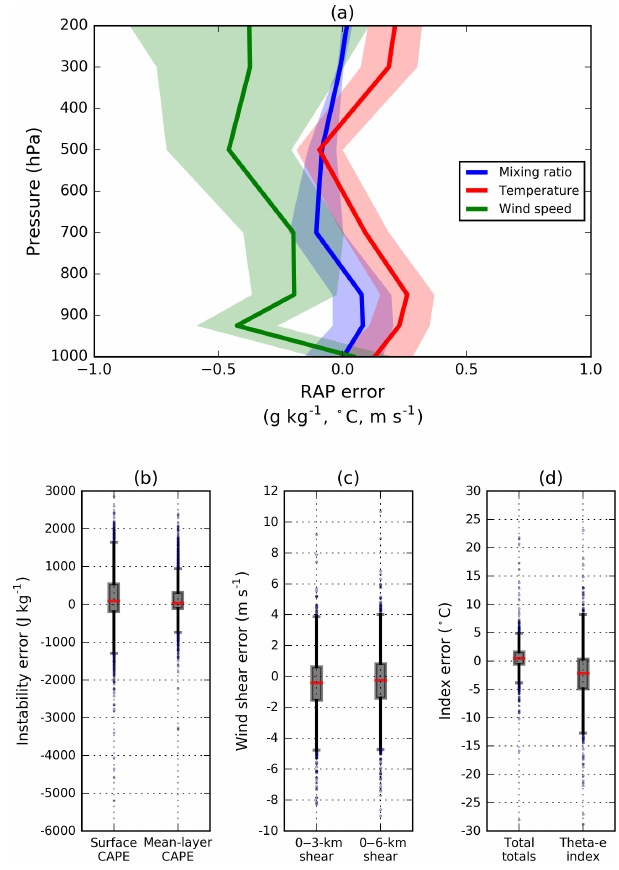
Figure 2. Vertical profiles of RAP output errors measured by co- located radiosonde observations (a) . Errors were calculated at 1000, 925, 850, 700, 500, 300, and 200hPa. The 95% confidence interval for the mean error (solid lines) is shaded. Box plots of the result- ing error for six derived quantities is shown in panels (b–d) . The interquartile range (IQR), representing the middle 50% of values, is depicted by the gray box. Values lying more than 1.5 × IQR from the median (red line) are marked with dots.